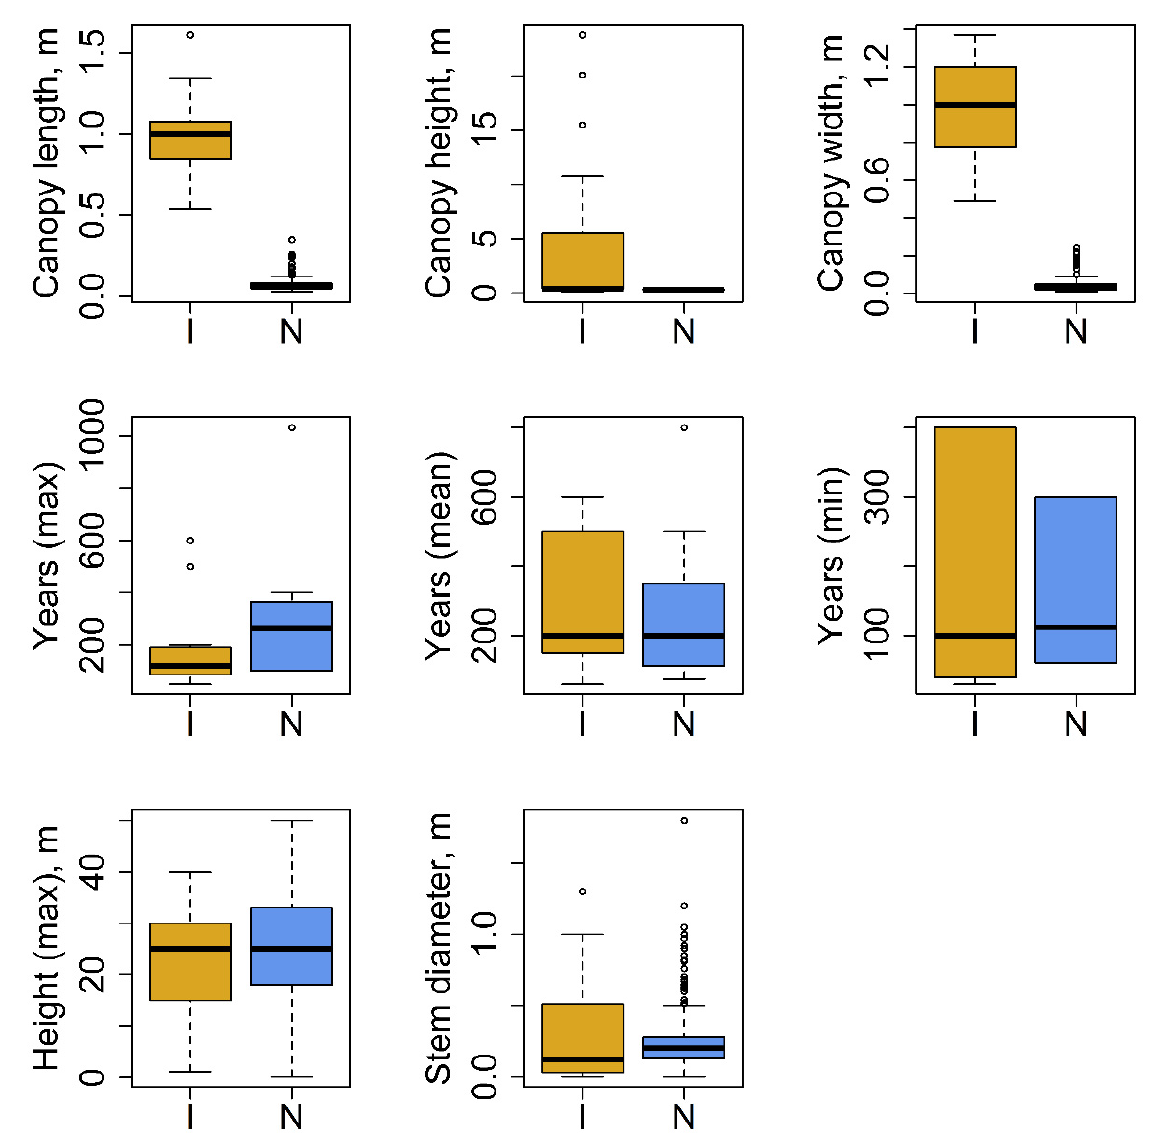
Figure 2. Plant architecture and plant lifespan data compared between native (N) and introduced (I) host plants of Lycorma delicatula . The trait names are as follows (from left to right, and from top to bottom): Crown (canopy) length: diameter along the longest axis; Crown (canopy) height; Crown (canopy) width; Plant lifespan (longevity) max; Plant lifespan (longevity) mean; Plant lifespan (longevity) min; Plant height vegetative max; and Stem diameter. Boxplots represent the median (thick horizontal line), the 25th and 75th percentiles (the box), the 5th and 95th percentiles (the whiskers). Crown (canopy) length and Crown (canopy) width only were significantly higher in introduced plants that those in native plants (LMM, fixed effects: p adj = 0.0007 and p adj = 0.0003, respectively). All other pairwise comparisons were not significant different at α = 0.05.